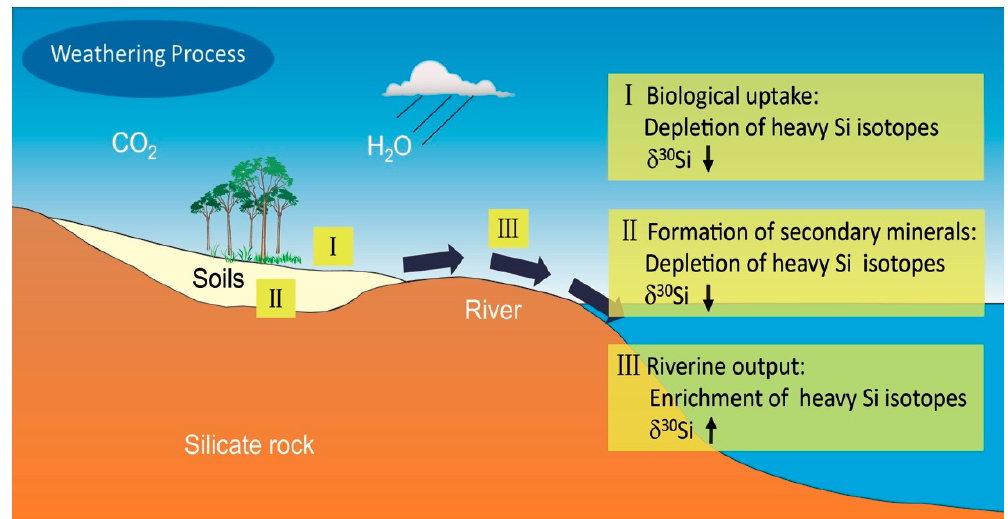
Figure 5. Schematic illustration of bonding structures of polymerized silicic acid with goethite ( a ) and ferrihydrite ( b ) minerals. Octahedra represent the atomic shells in iron oxy-hydroxide minerals.